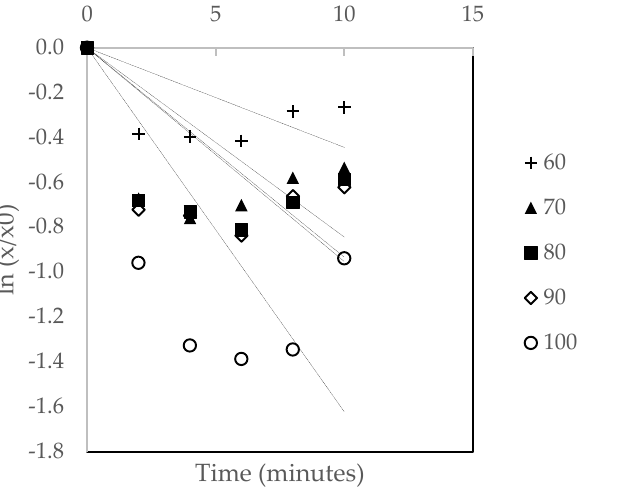
Figure 6. First-order kinetic model of the effect of blanching (60, 70, 80, 90 and 100 ◦ C) on the firmness of Dabai fruit.